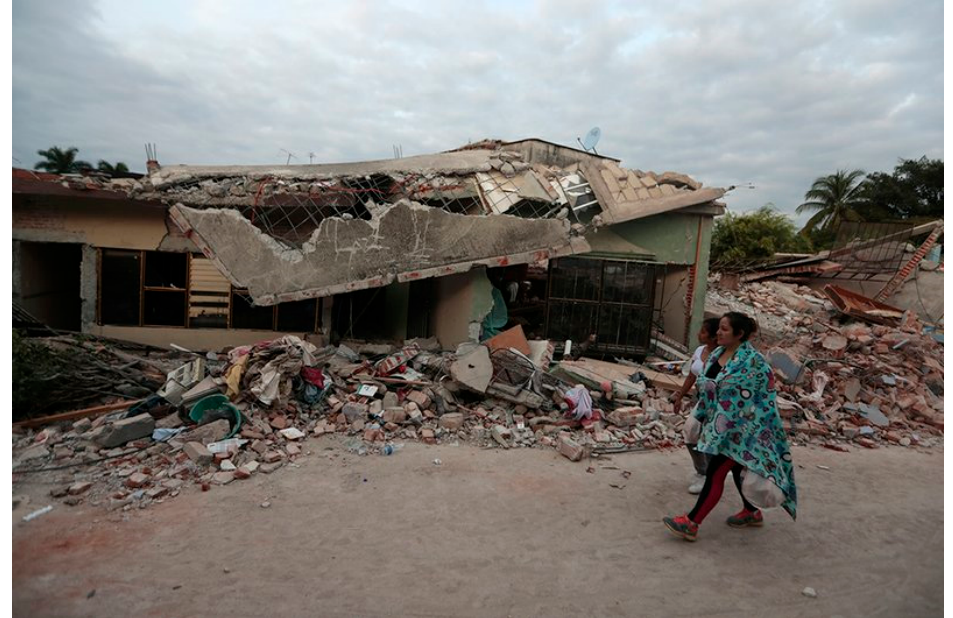
Figure 1. An image of a destroyed building in Jojutla, Morelos, a rural town close to the epicenter of the 2017 Puebla earthquake [28].